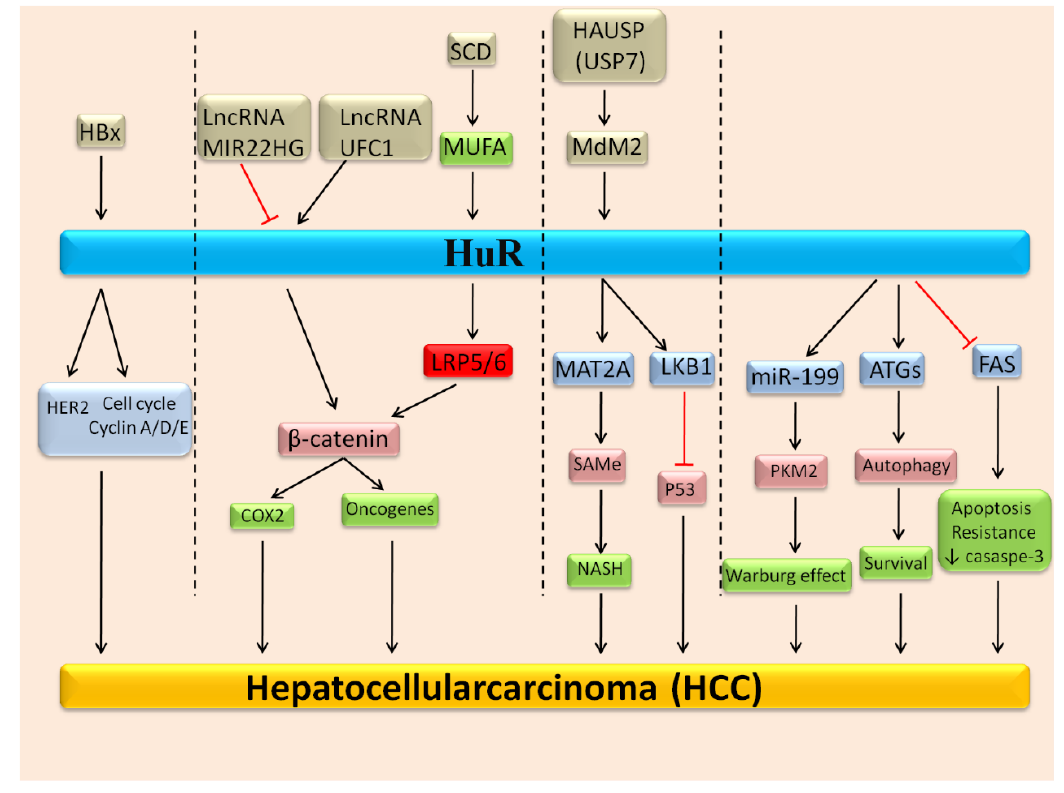
Figure 1. Molecular mechanisms that trigger the activation of HuR and its downstream axis that are participated in the progression of hepatocellularcarcinoma (HCC).